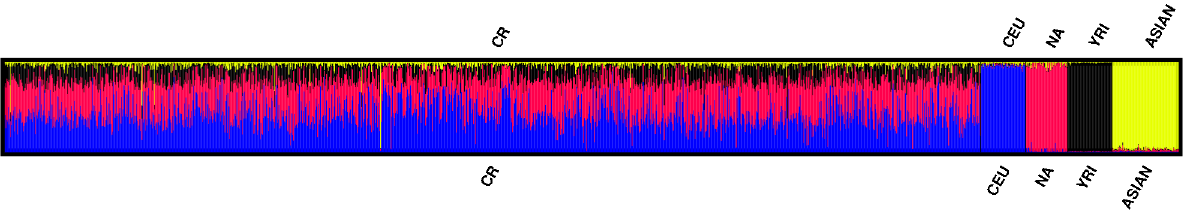
Figure 2. Spectrum plot of admixture coefficients. The admixture coefficient for each sample was the average of 10 independent unsupervised STRUCTURE runs, all with K=4, which turned out to be the optimal K for the total sample set including CR samples and four continental reference populations (see Figure S1).